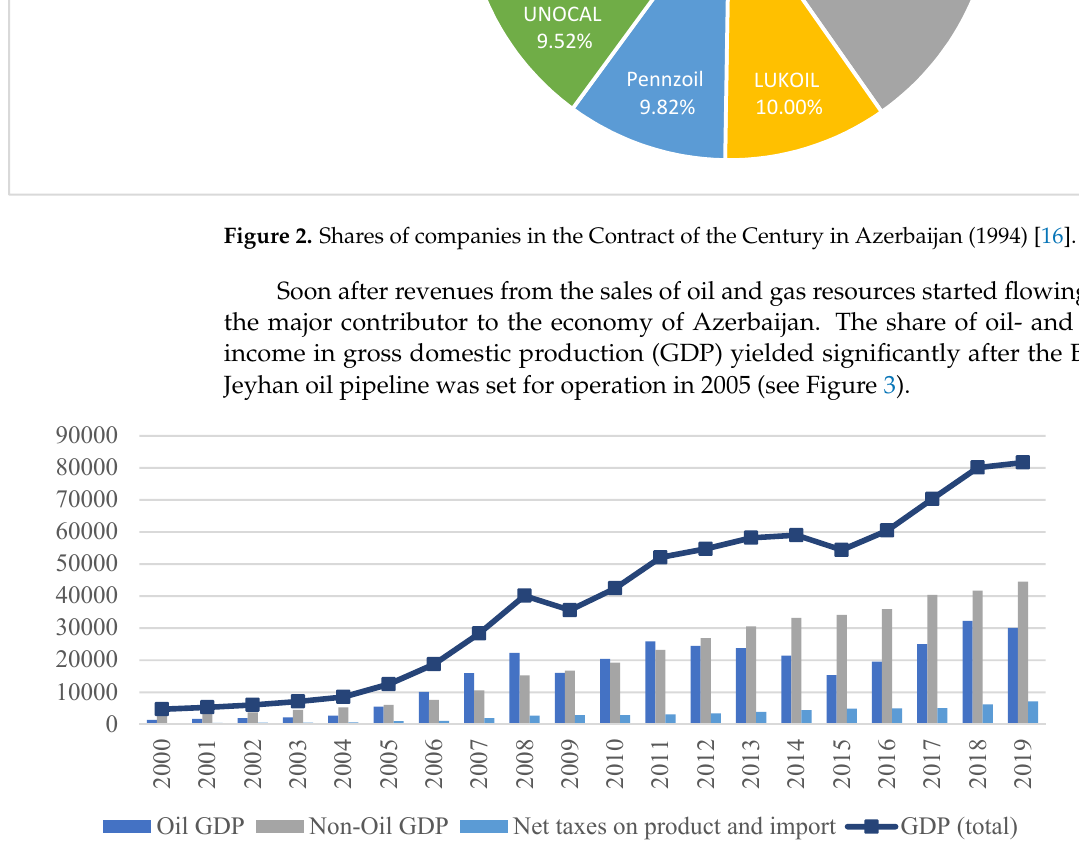
Figure 3. Composition of GDP of Azerbaijan in million AZN [17] (USD 1 equals to AZN 1.7 as of 18 October 2021. Exchange rates are fixed and managed by the Central Bank of Azerbaijan (www.cbar.az, accessed on 18 October 2021). Average inflation rate for 2000–2020 in Azerbaijan constitutes 6.39% [18]).